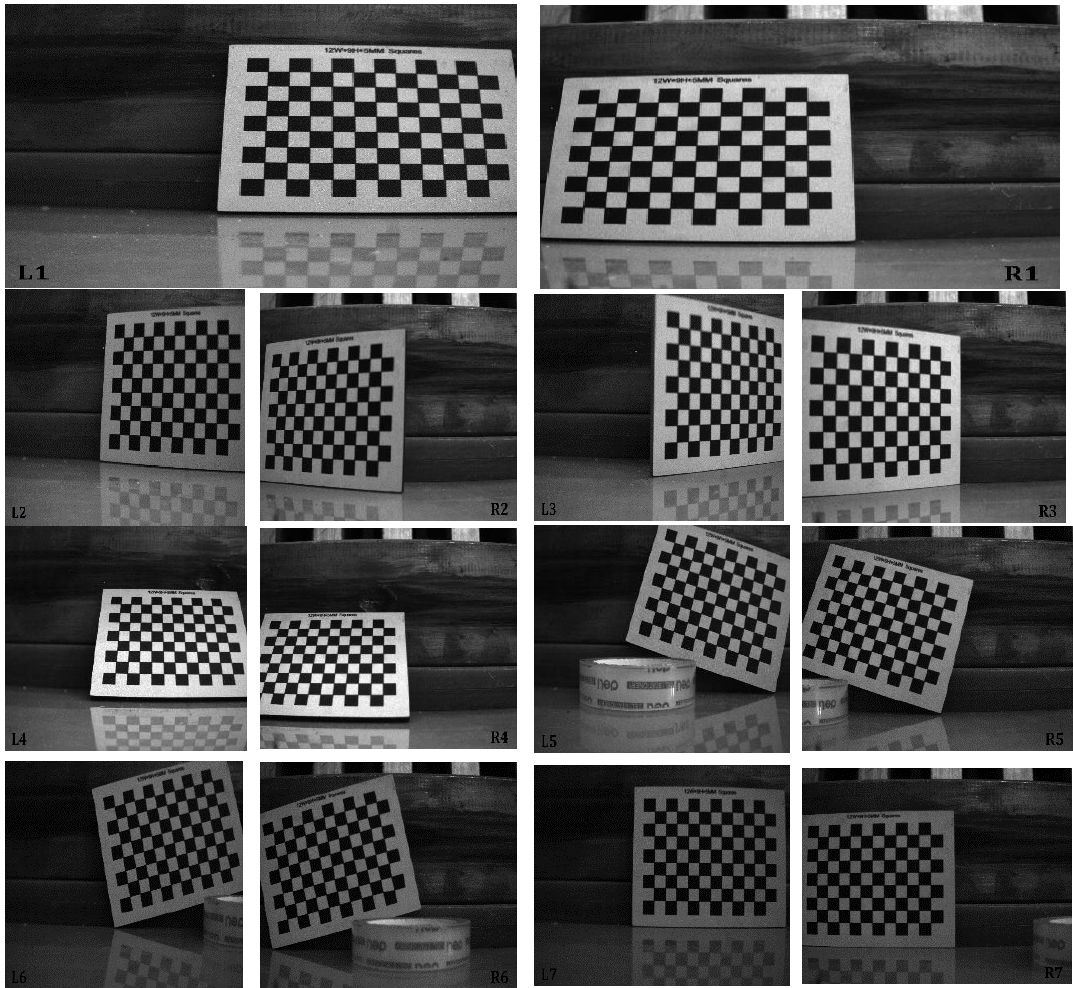
Figure 10. Seven sets of images of calibration boards of different poses obtained by the left and right cameras. Figures, L1 – L7 were captured by left camera. Figures, R1 – R7 were captured by right camera. Table 2. External parameters of binocular